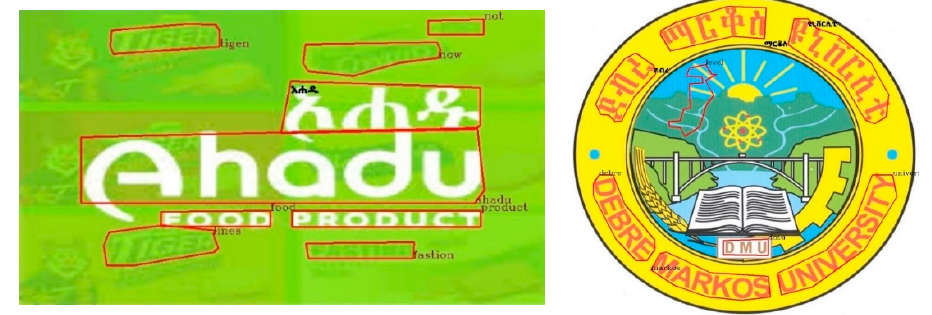
Figure 4. Sample detection and recognition result for our prepared dataset .